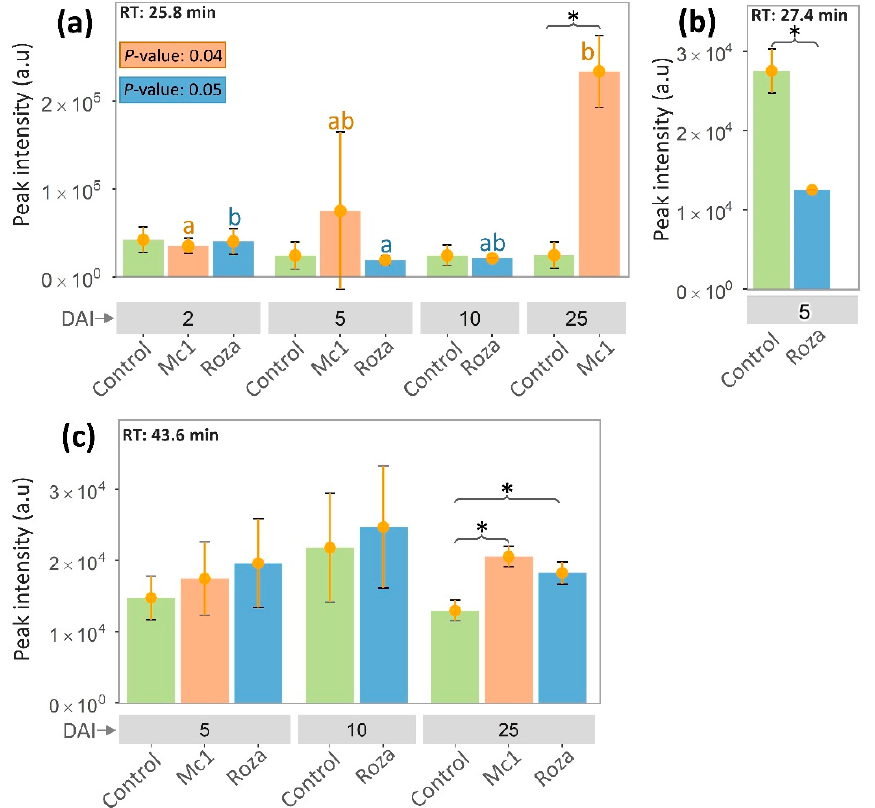
Figure 3. Peak intensity of three common retention times across different days after inoculation of SB22 plants with M. chitwoodi Race 1 (Mc1) and its pathotype Roza. Retention time: ( a ) 25.8 min, ( b ) 43.6 min, and ( c ) 27.4 min. * p -value < 0.05 from t -test analysis. Different letters in each column by nematode race denote significant differences in peak intensities across DAIs at p < 0.05 using Tukey’s test. Heatmap (Figure 4) of average peak intensities of VOCs across the combined dataset shows variations in VOCs emission profiles between control, Mc1 inoculated, and Roza inoculated SB22 plants. In general, VOC peaks at 21.5, 23.1, and 25.9 RTs showed the high- est peak intensities across the samples, although the differences were not statistically sig- nificant.